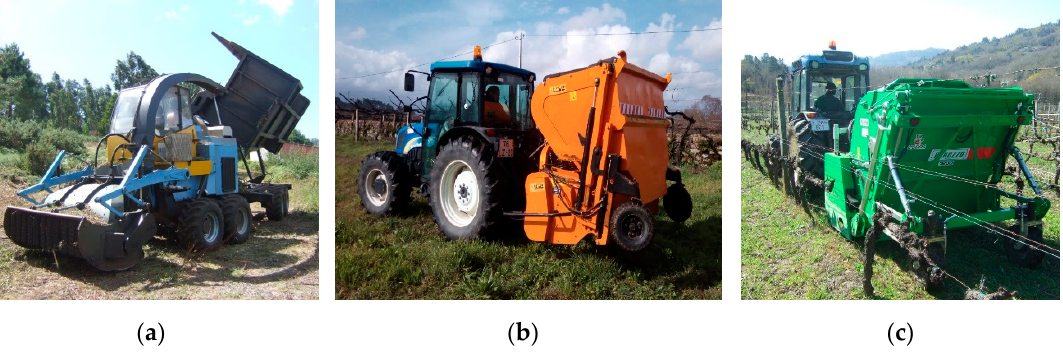
Figure 1. Specific machine tested ( a ) “Retrabio”, ( b ) Berti Picker and ( c ) Peruzzo Cobra Collina.